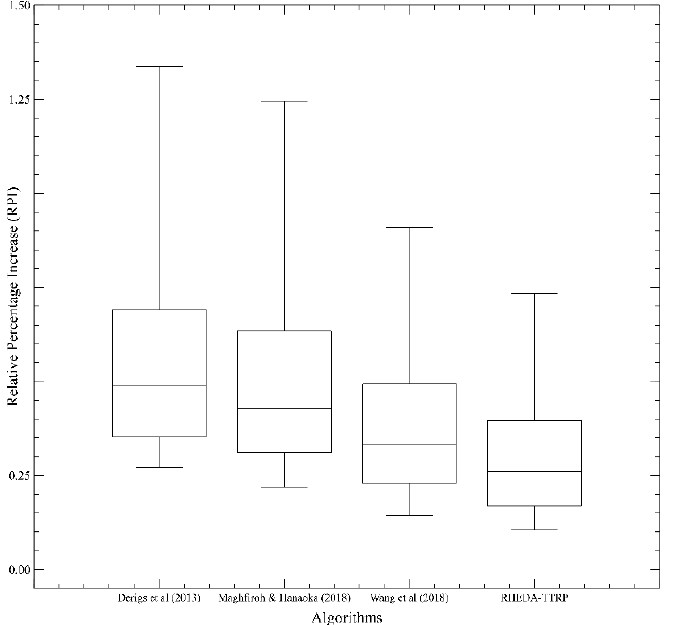
Figure 11. Algorithm Performance for the TTRP using the relative percentage increase [37–39]. The computational time comparison is depicted in Figure 12.